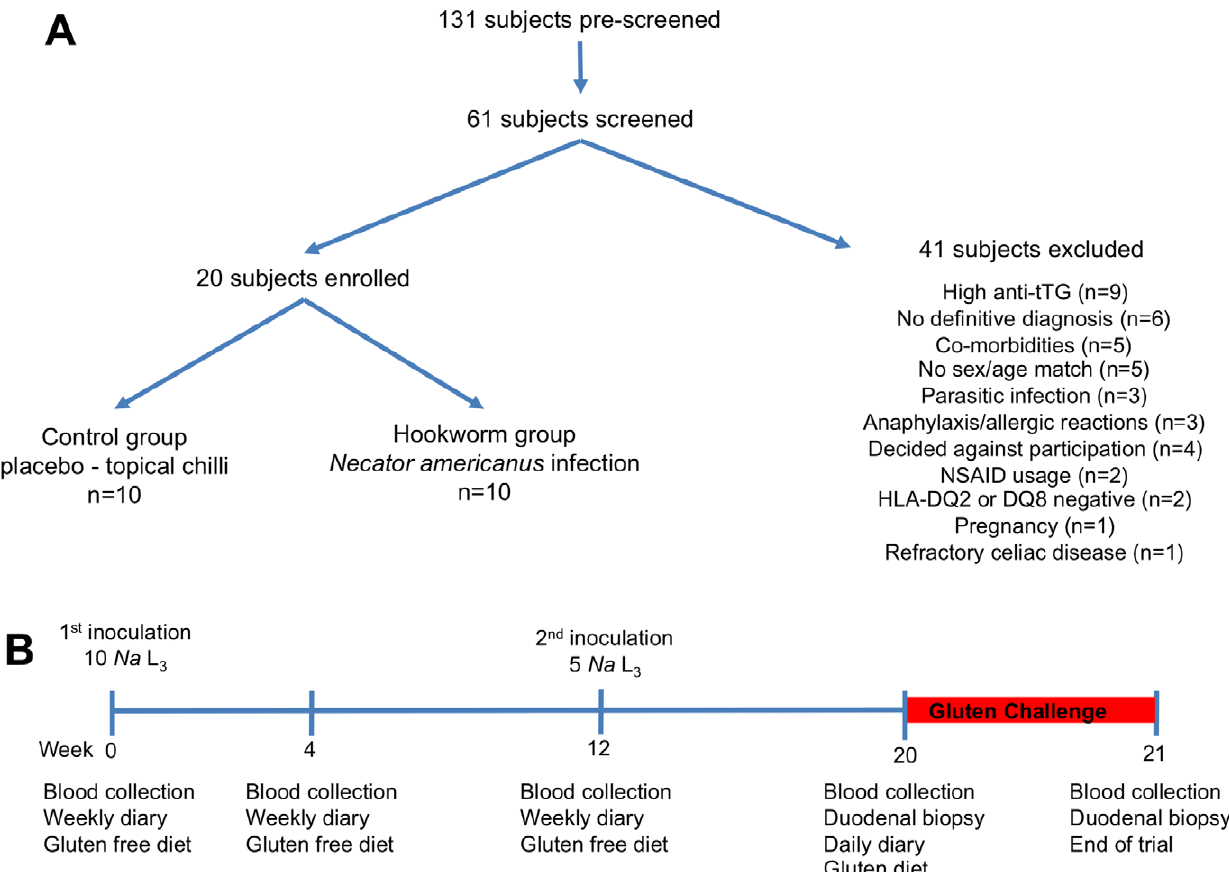
Figure 2. Recruitment and Protocol. Recruitment and summation of those excluded post screening (A), and trial outline (B).